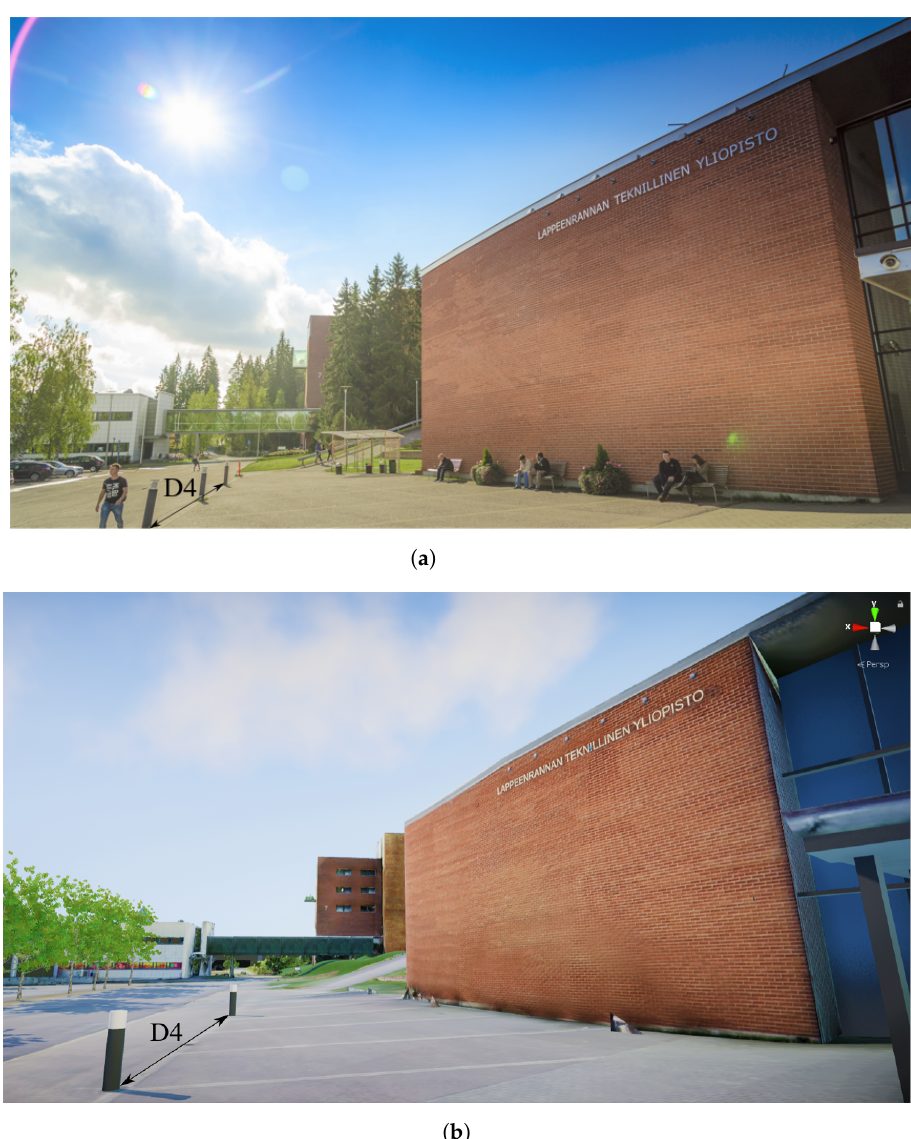
Figure 13. Comparison between the textures in the real world and created in the graphical software using the photogrammetry-based approach: ( a ) Real world and ( b ) Unity environment. Table 1. The distance values shown in Figures 12a,b and